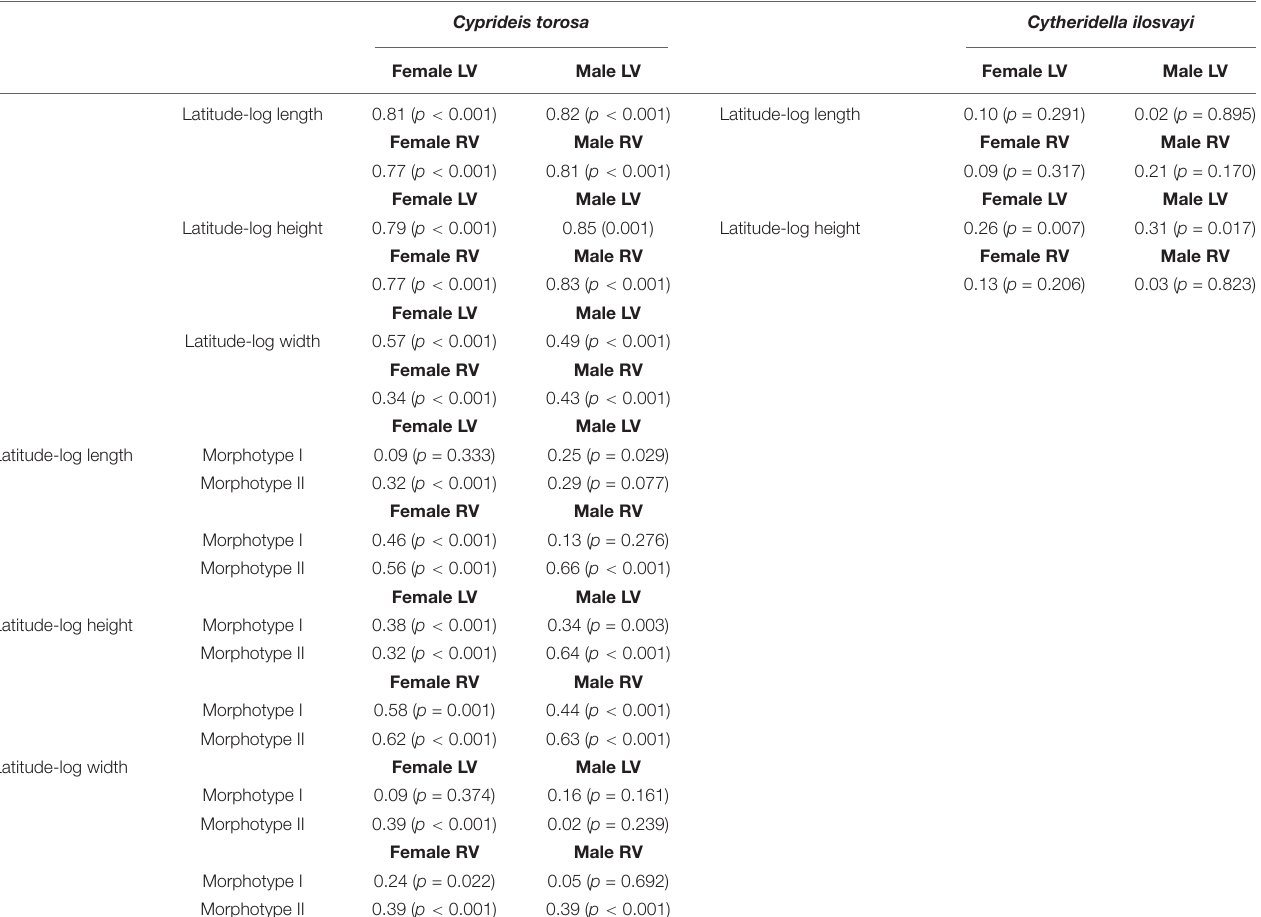
TABLE 4 | Regression coefficients of log-transformed size-latitude relationships for Cyprideis torosa and Cytheridella ilosvayi separated for sexes and left and right valves (LV and RV,